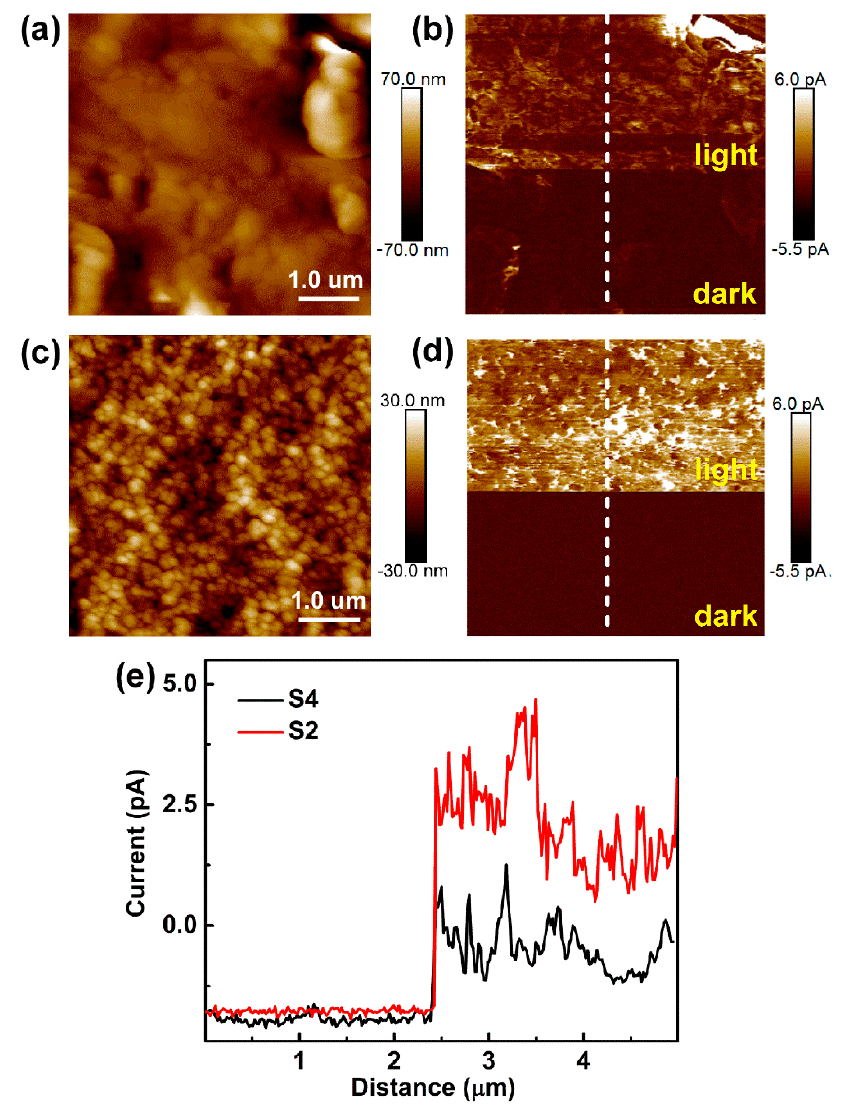
Figure 3. ( a , c ) Topographies and ( b , d ) photoconductive images of sample S4 (MAI:PbI 2 ratio 1:1) and S2 (MAI:PbI 2 ratio 0.5:1) under dark and 532 nm laser illumination, respectively. ( e ) Surface profile of current mapping taken from ( b ) and ( d ) at the location marked by the white dashed lines, showing the surface current change at 1 V of sample S2 (MAI:PbI 2 ratio 0.5:1) and S4 (MAI:PbI 2 ratio 1:1) in the dark and under illumination.